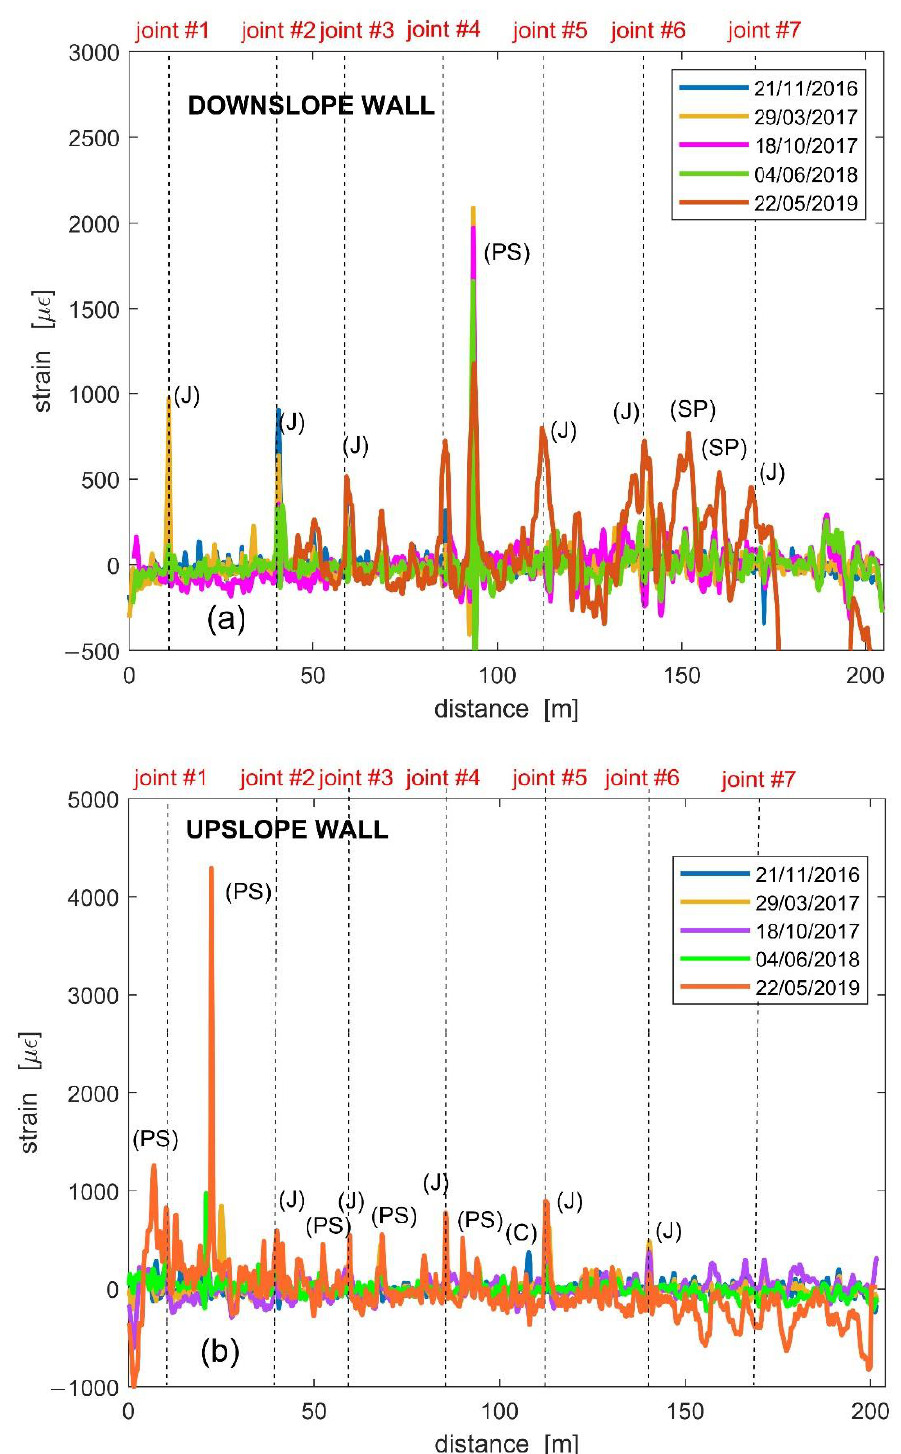
Figure 9. Results of the optical fiber strain measurement along the ( a ) downslope and ( b ) upslope tunnel wall, with indication of the position of joints. J — Joint, PS — local Parget Swelling, SP — Salt Precipitate accumulation, C — Crack.